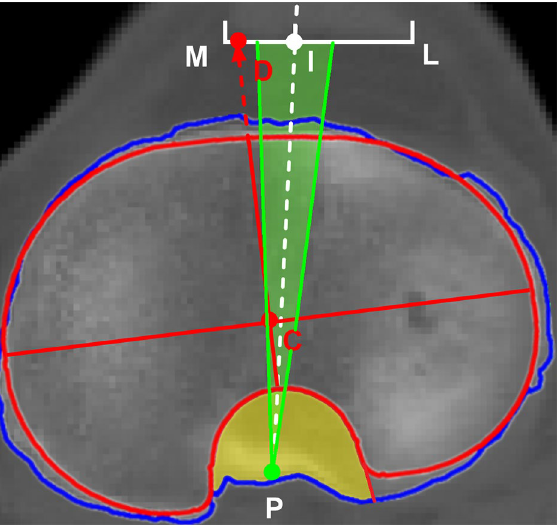
Figure 3. The composite image of the matched contours over the corresponding resected plane. The line CD was defined as the AP axis of the baseplate. The line PI was defined as the Insall line. The angles between the AP axis and the line PI were measured and recorded as the rotational degree. The percentage position of the baseplate AP axis over the patellar tendon was defined as the length of MD divided by the length of ML. The yellow area indicated the uncovered posterior cruciate ligament (PCL) zone. The green area indicated ± 5° rotation interval with respect to the Insall line. ML: the patellar tendon width. C: The centroid of the baseplate. D: The intersecting point of the baseplate AP axis extension over the patellar tendon. I: The medial 1/3 point of the patellar tendon. P: The projected middle of the PCL insertion